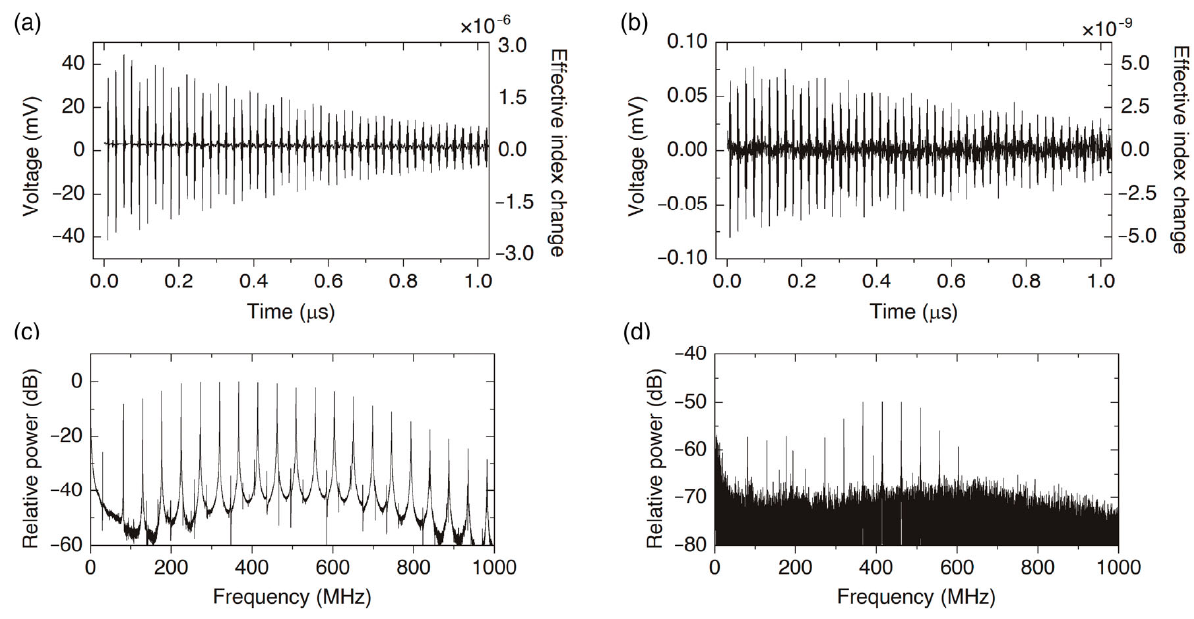
Figure 2. Oscilloscope traces for pump pulses of ( a ) 7 kW and ( b ) 20 W. Each one of the traces is the result of 1064 averages. ( c , d ) The fast Fourier transform of traces ( a ) and ( b ): SNR > 40 dB and 15 dB can be observed, respectively, for the strongest resonances.